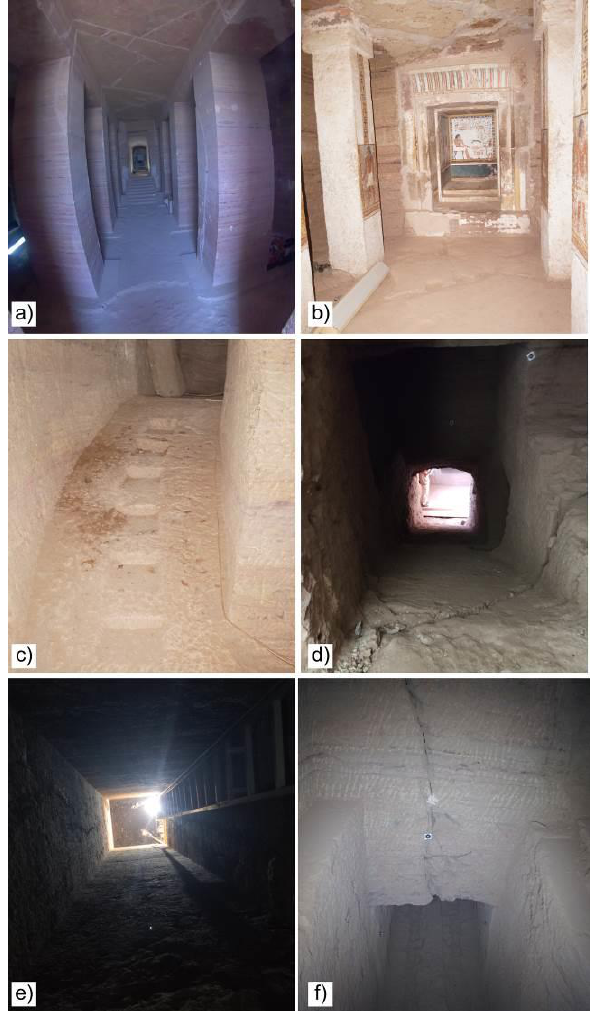
Figure 2. Examples of interior spaces: a) QH31 hypostyle